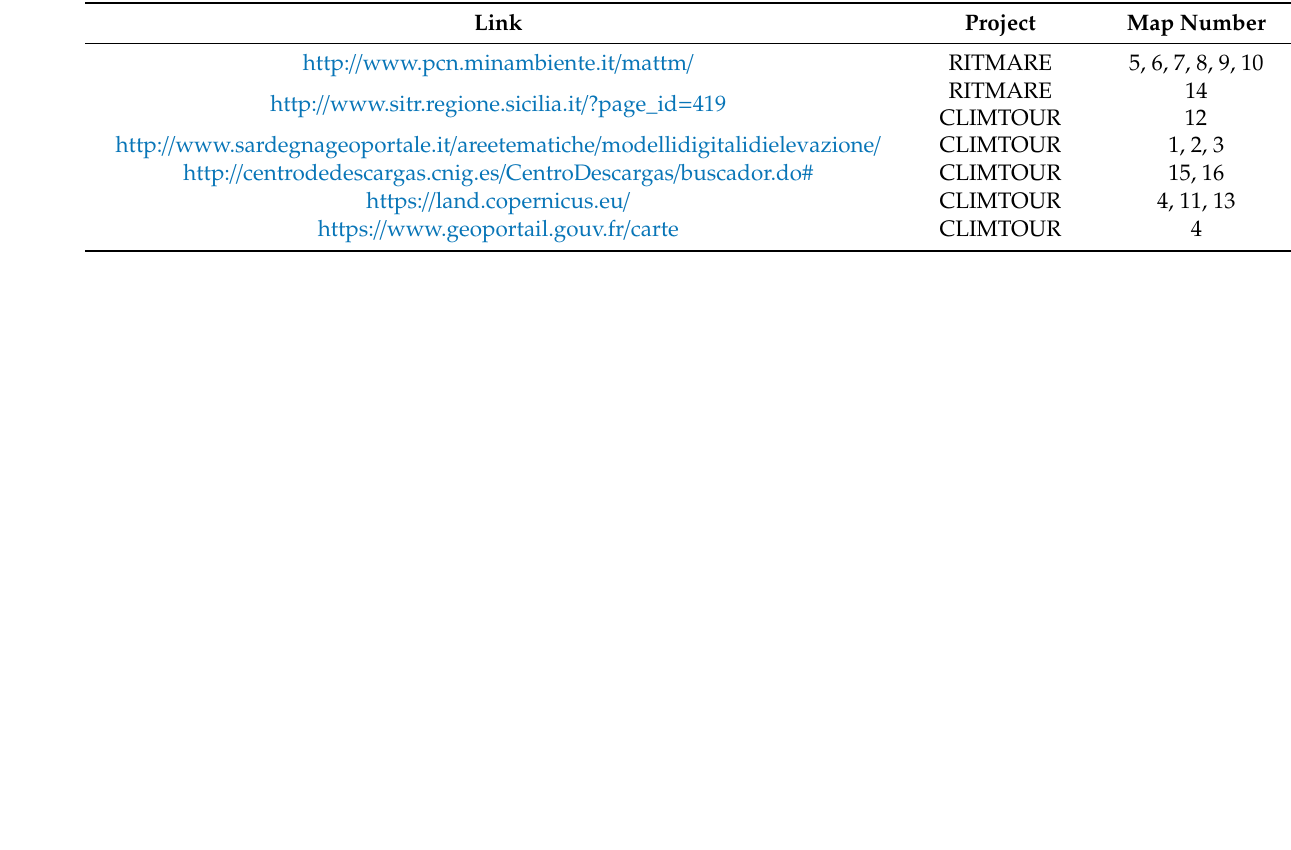
Table 2. Link to the websites and data